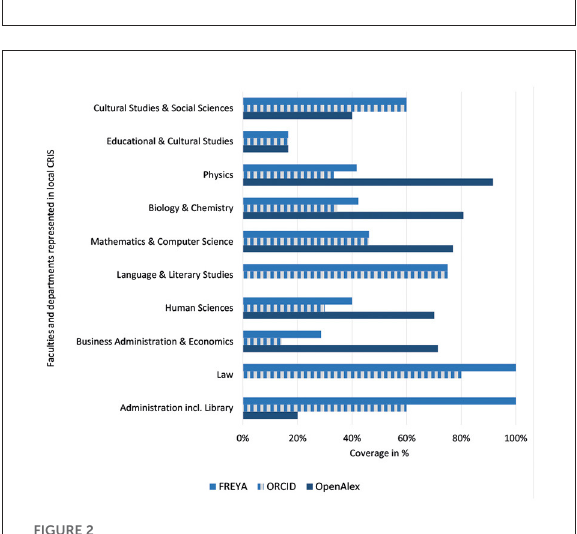
FIGURE1 ORCID coverage for researchers (UOS) in total in external data sources.